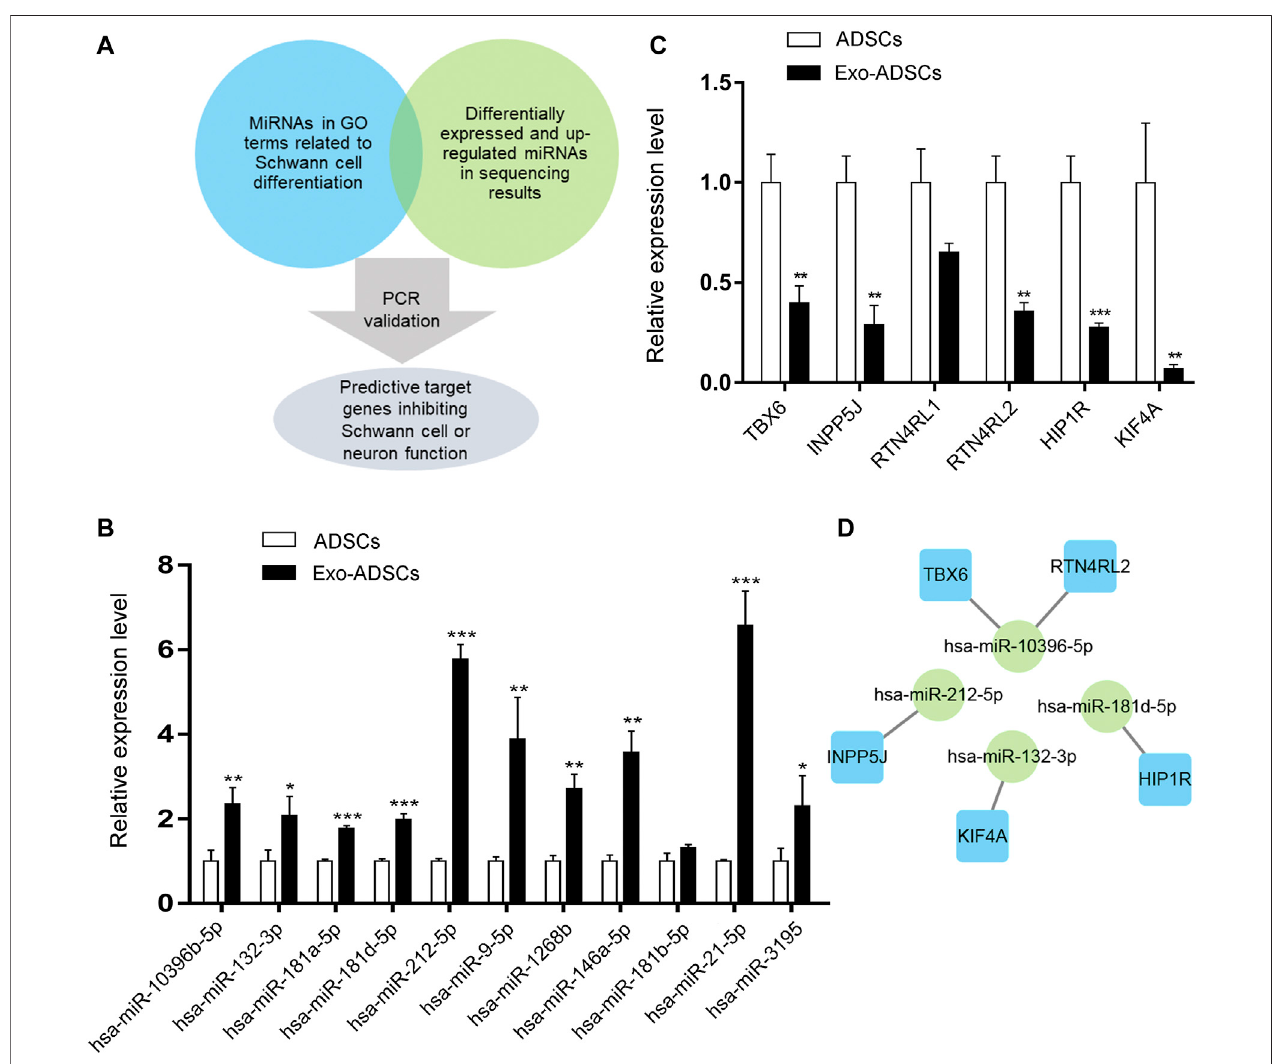
FIGURE 6 | MiRNAs and target genes validation. (A) Mind map for miRNAs and target genes screening. (B) RT-qPCR analysis to validate the expression of the selected miRNAs in ADSCs and Exo-ADSCs. (C) RT-qPCR analysis to validate the expression of the selected target genes in ADSCs and Exo-ADSCs. (D) The miRNA- gene-network based on the validated miRNAs and their target mRNAs. Green circular nodes represent the validated miRNAs, whose target mRNAs were validated by RT-qPCR. Blue square nodes represent their validated target mRNAs. The results were presented as the mean ± SD ( n (cid:1) 3 independent experiments). * p < 0.05, ** p < 0.01, *** p <